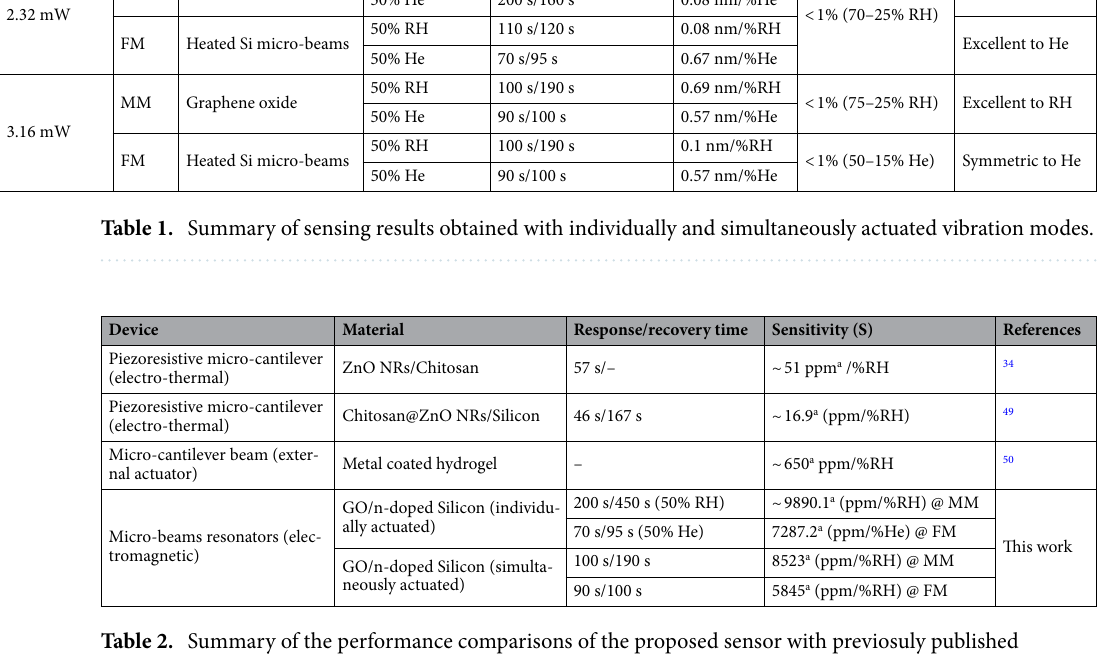
Table 2. Summary of the performance comparisons of the proposed sensor with previosuly published (cid:31) for (cid:31) A × 10 6 where (cid:31) f and (cid:31) A is change in frequency and MEMS based gas sensors. a S (ppm) = f o orA o × (cid:31) % targetanalyte amplitude after gas exposure, f o and A o is baseline frequency and